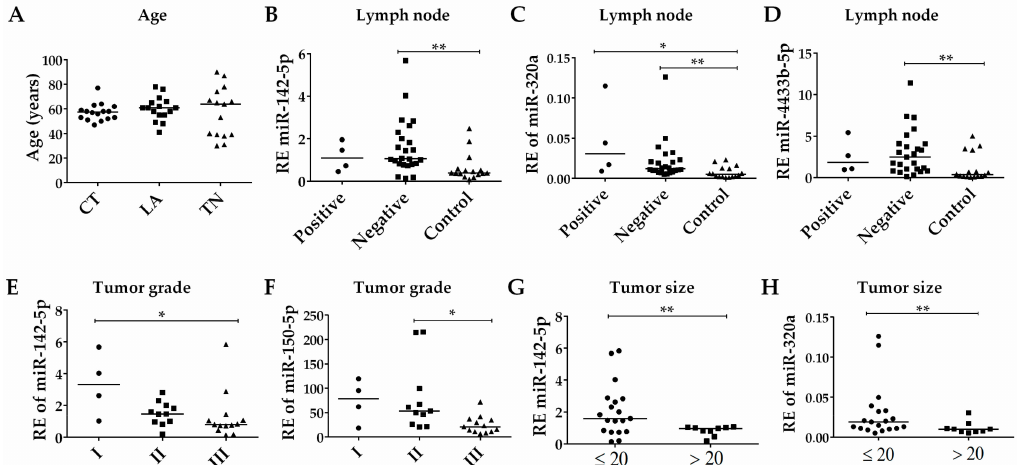
Figure 4. Comparison of EV-miRNAs expression to clinicopathological data. ( A ) No di ff erence was observed between the patients’ ages for the evaluated groups: control (CT), Luminal A (LA), and Triple-negative (TNBC). ( B ) Significant down-relative expression (RE) of miR-142-5p in controls compared to patients negative for lymph node metastasis ( p < 0.01). ( C ) Significant increase in levels of miR-320a in patients with BC, independent of lymph node metastasis status ( p < 0.05 for both). ( D ) Patients without lymph node metastasis still present higher levels of miR-4433b-5p compared to controls ( p < 0.01). ( E ) Significant reduction in miR-142-5p ( p < 0.05) between tumor grade I and III. ( F ) No significant alteration of miR-150-5p among tumor grades. ( G ) Bigger tumors ( > 20 mm) have decreased levels of miR-142-5p ( p < 0.01), and ( H ) miR-320a ( p < 0.01). * p < 0.05, ** p < 0.01. Analysis were calculated based on relative quantification (RQ)